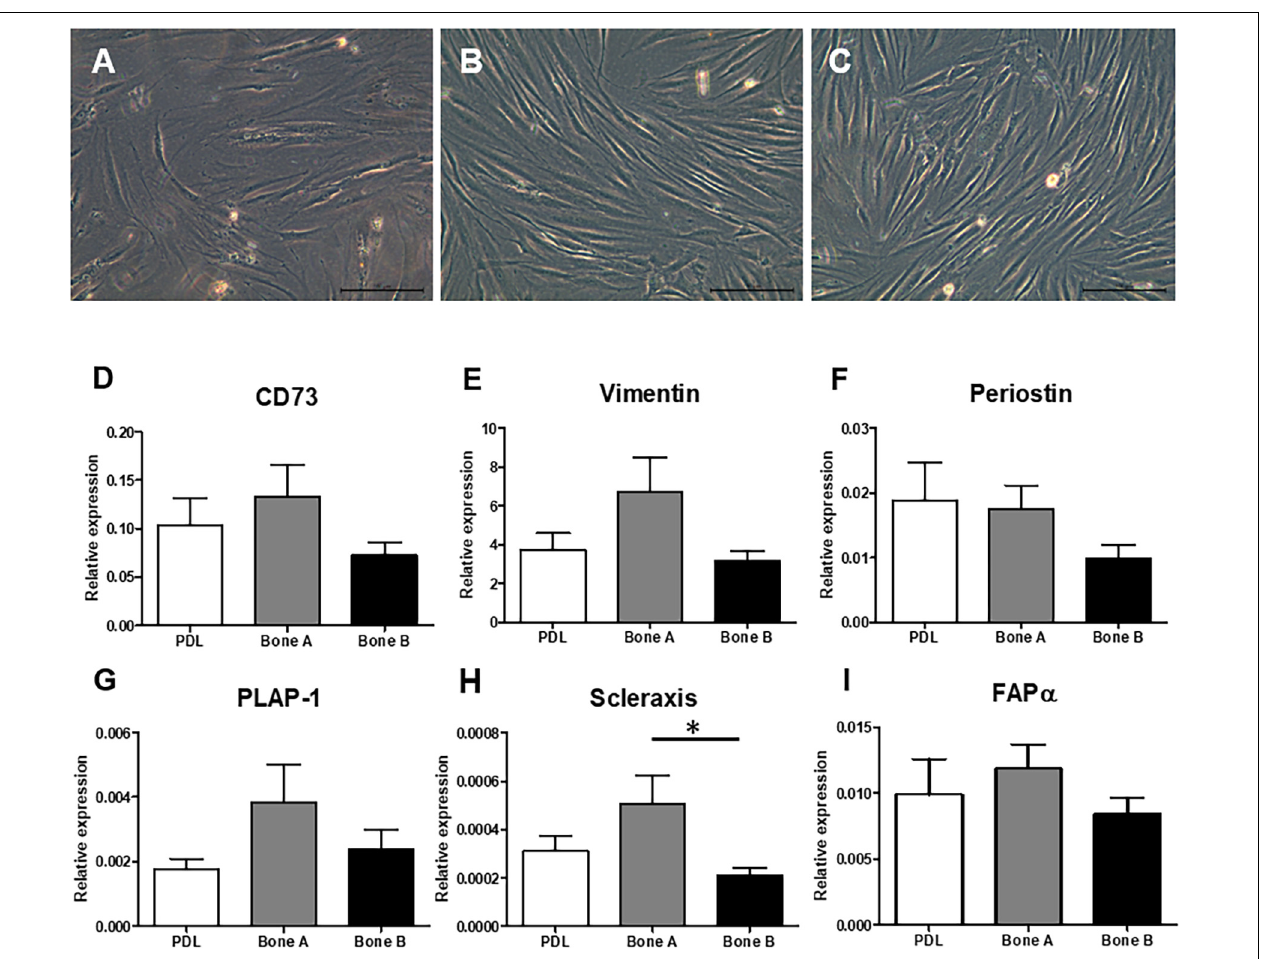
FIGURE 2 | Fibroblast appearance of (A) PDL derived cells and alveolar bone derived cells (B) bone A and (C) bone B from patient 1. Images were taken prior to the start of the experiments. Only culture medium (DMEM) was added. These cells were not subjected to osteogenic or osteoclastogenic medium. Bar = 100 µ m. Analysis of gene expression of mesenchymal markers (D) CD73, (E) Vimentin, (F) Periostin, (G) PLAP-1, (H) Scleraxis, and (I) FAP α revealed similar gene expression between the cells ( n = 7). Expression was relative to housekeeping gene HPRT. ∗ p < 0.05 (Friedman test with Dunn’s multiple comparison post hoc